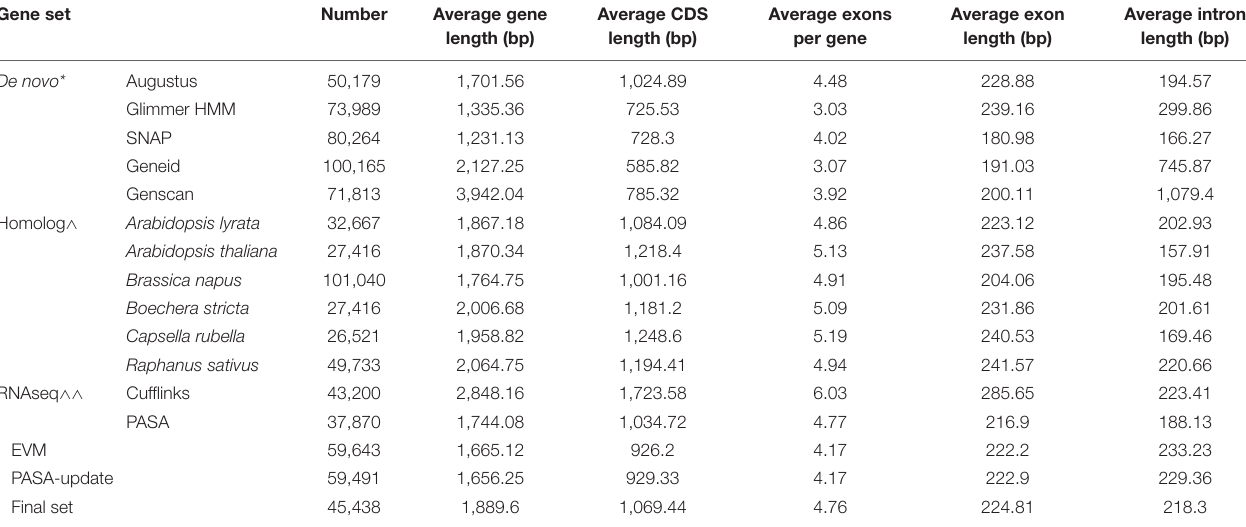
TABLE 3 | Predicted protein-coding genes within the E. sativa reference